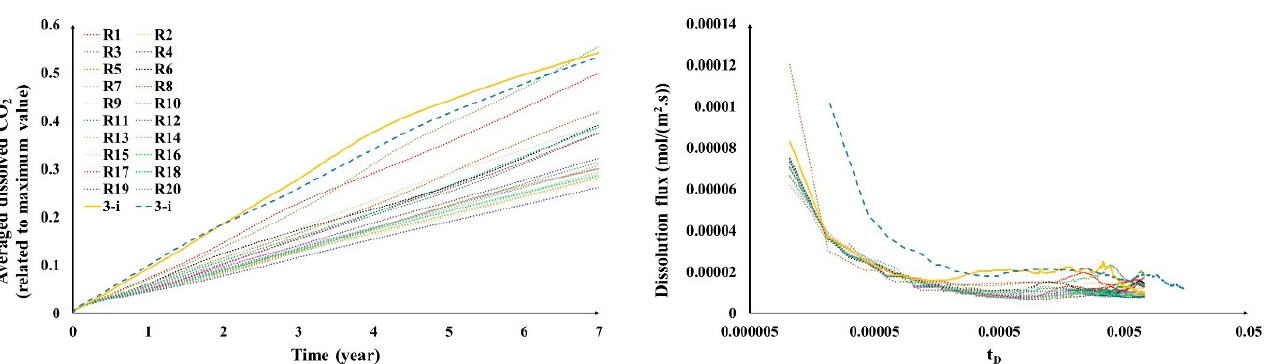
Figure 8. The heterogeneous realizations (dotted lines), homogeneous with considering cross-diffusion (solid line), and homogeneous without considering cross-diffusion (dashed line) averaged dissolved CO 2 and dissolution flux for case 2-i. Legends for left- and right-hand subplots are same.